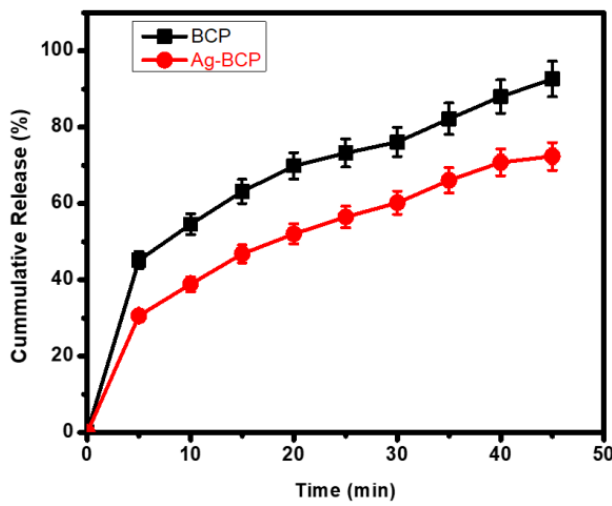
Figure 12. Comparison of CIP release behavior of BCP and Ag-BCP.